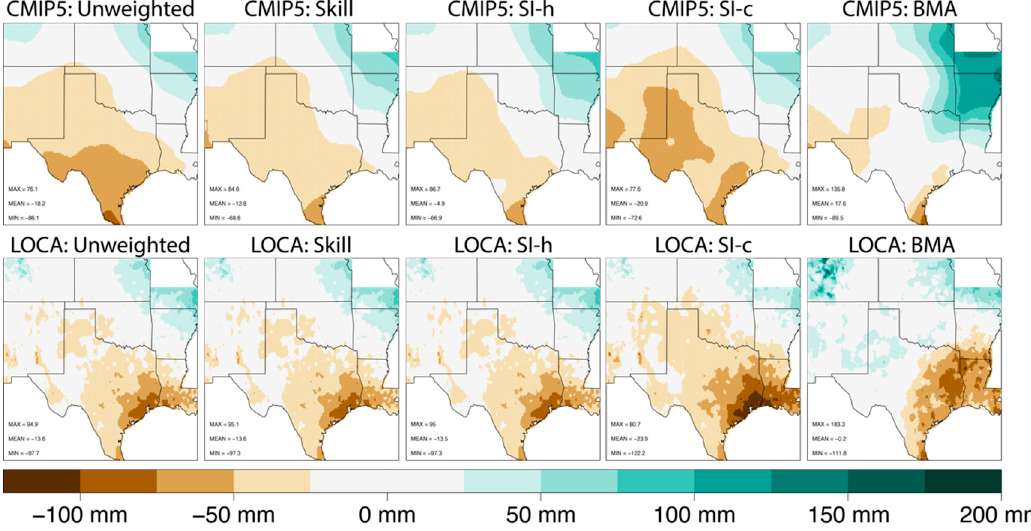
Figure 7. Projected change (mm) in annual average precipitation from the unweighted ensembles (left hand column) and all eight weighted ensembles.